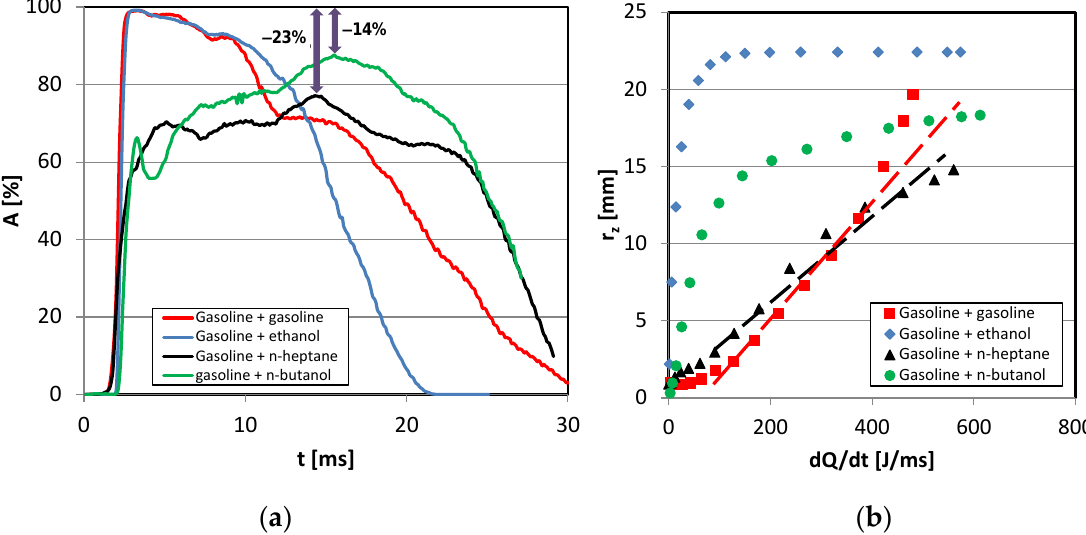
Figure 9. Combustion process indicators: ( a ) comparison of the time characteristics of the percentage share of the combustion chamber cross-sectional area occupied by the flame for the combustion of gasoline with other fuels supplied with separate injectors; ( b ) relationships between the equivalent flame area radius and the heat release rate during the growth of these quantities for the combustion of fuel mixtures supplied with separate direct injectors.